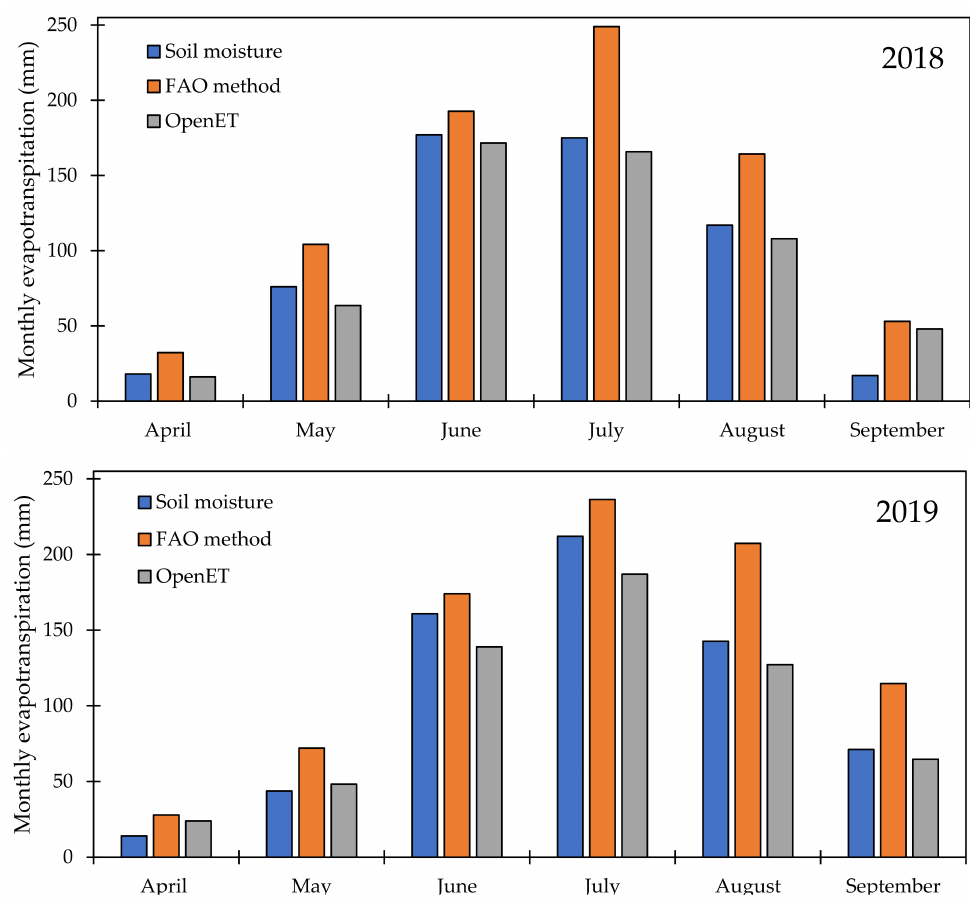
Figure 10. Comparison of potato monthly evapotranspiration estimated by the soil moisture, FAO method and OpenET during the 2018 and 2019 growing